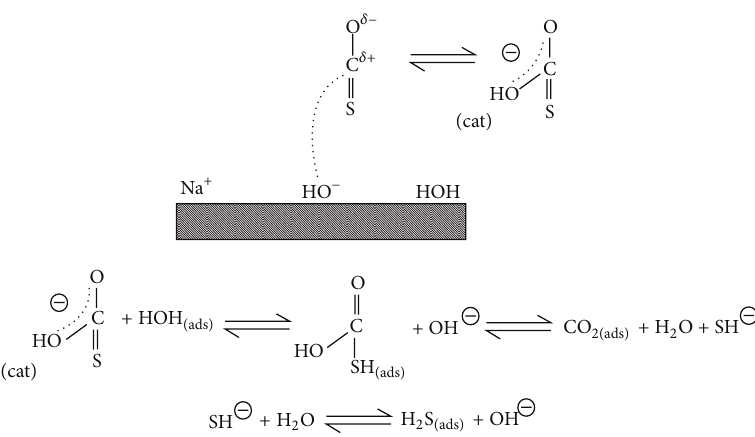
Figure 2: The concerted mechanism as proposed by George